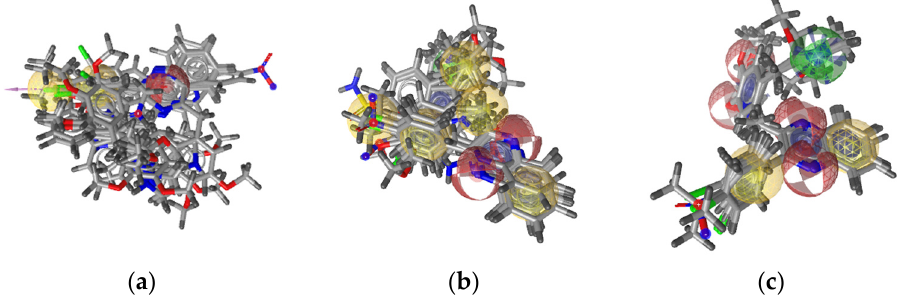
Figure 5. Visualization of results in LigandScout for three groups set1 ( a ), set2 ( b ) and set3 ( c ).